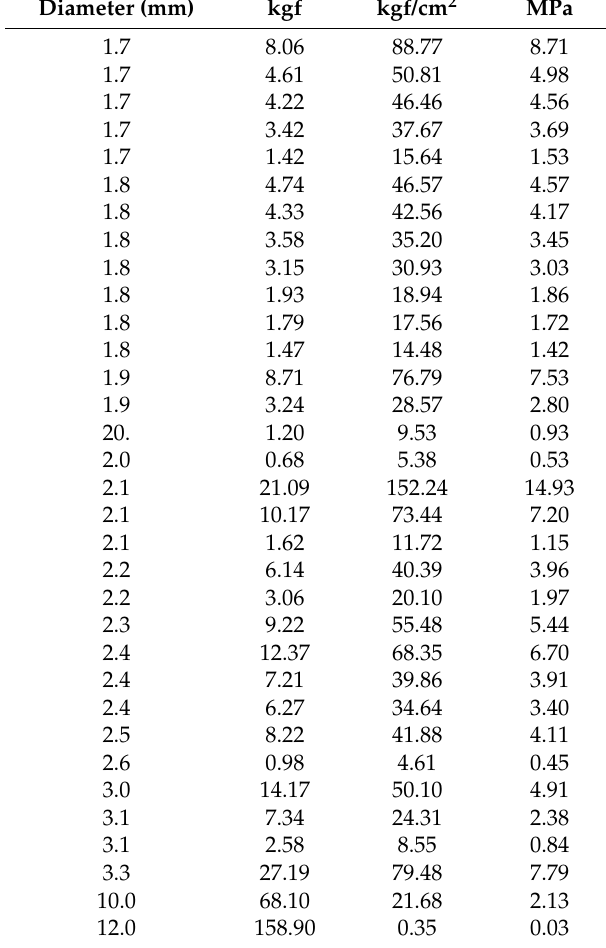
Table A8. Summary of all root tensile strengths, in MPa, measured for Salix laevigata . Plant Type